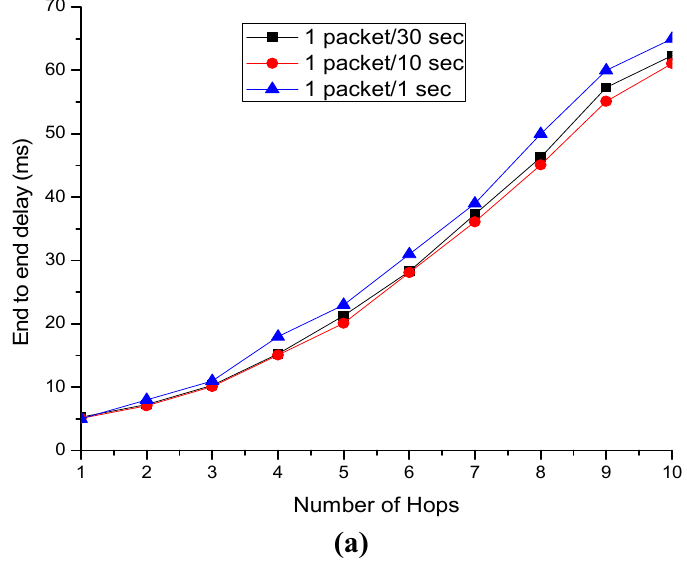
Figure 22. End to end delay vs. number of hops. ( a ) Multiple nodes to SMAG delivery dela; ( b ) End-to-end